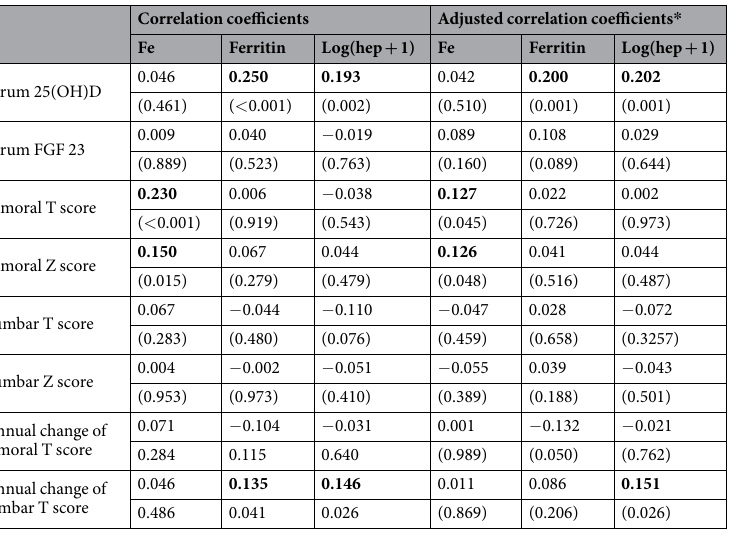
Table 2. Correlations between serum iron, ferritin, and hepcidin levels and other parameters. * Adjusted for age, sex, BMI, eGFR, CRP, PSL use, bDMARD use, anti-resorption drug use, teriparatide use, and iron agent use. eGFR, estimated glomerular filtration rate; UIBC, unsaturated iron binding capacity; DAS28, disease activity scores in 28 joints; ESR, erythrocyte sedimentation rate; CRP, C-reactive protein; SDAI, simplified disease activity index; CDAI, clinical disease activity index; HAQ-DI, health assessment questionnaire without disability index; MMP-3, matrix metalloprotease 3; PSL, prednisolone; MTX, methotrexate;